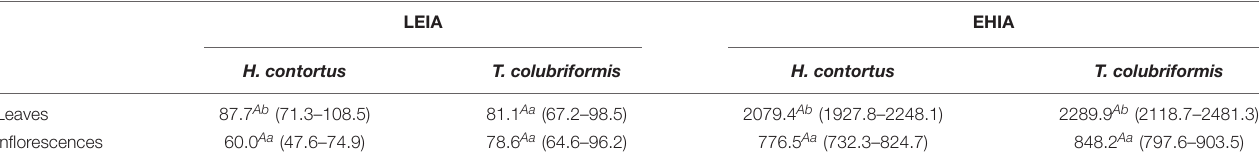
TABLE 2 | Effective concentration that inhibits 50% of larval exsheathment or egg hatching (EC 50 values, µ g mL − 1 ) and 95% confidence intervals (CI) obtained for Cladium mariscus (L.) Pohl (sawgrass) organ extracts on Haemonchus contortus and Trichostrongylus colubriformis L3 larvae exsheathment (LEIA) and egg hatching inhibition assays